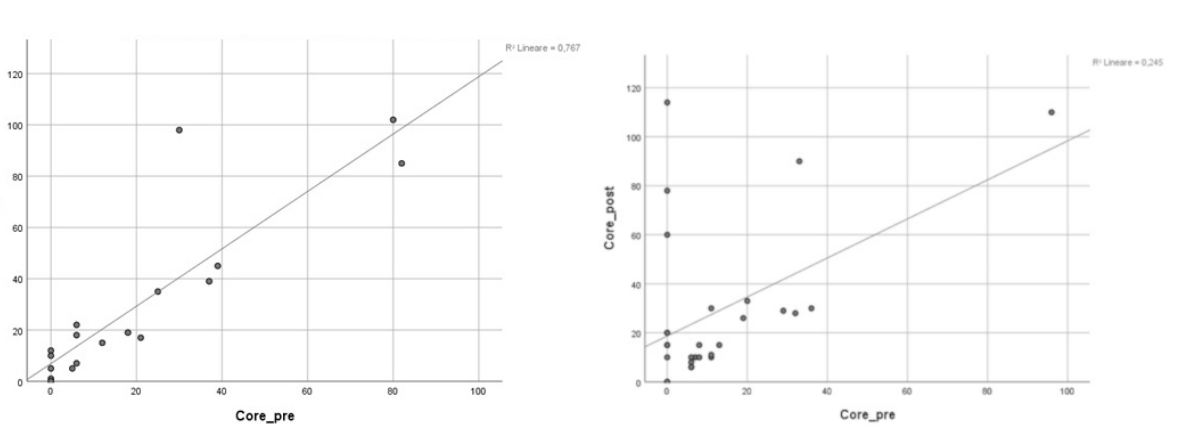
Figure 3. Secondary analysis scatter plot between PIC and FIV in the tandem group (on the left ) and the MCA-LVO control group (on the right ).